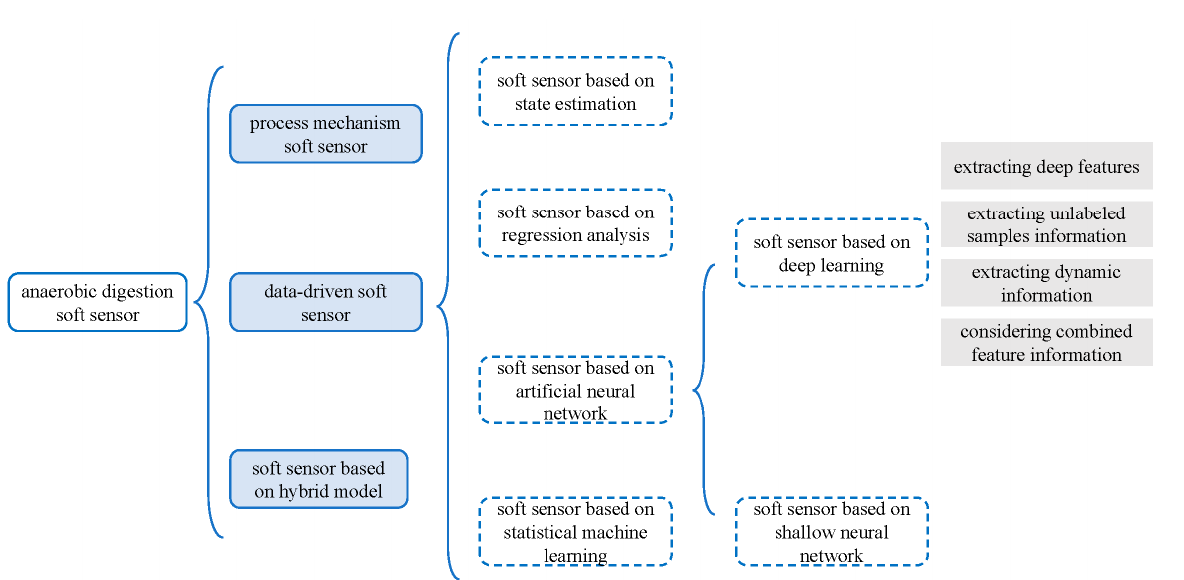
Figure 9. The general idea of this paper.